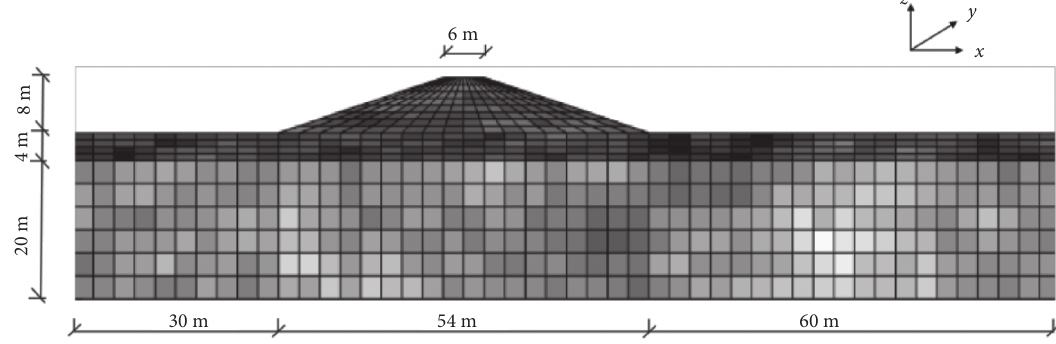
Figure 1: Dimension of the multilayer embankment. Table 1: Hydraulic conductivity of the embankment soil. Soil